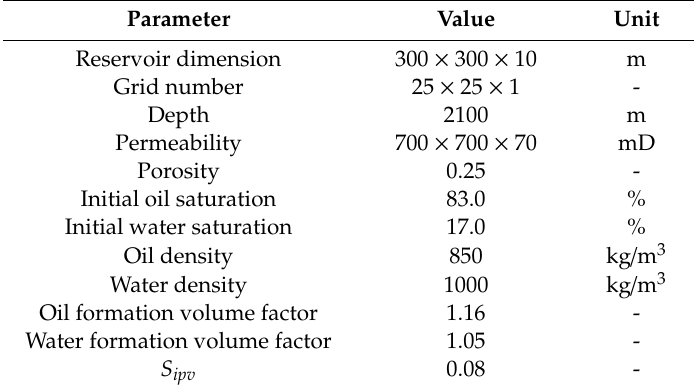
Figure 5. The model of the five-spot pattern in the case study. Table 2. The parameters of the basic reservoir’s properties in the case